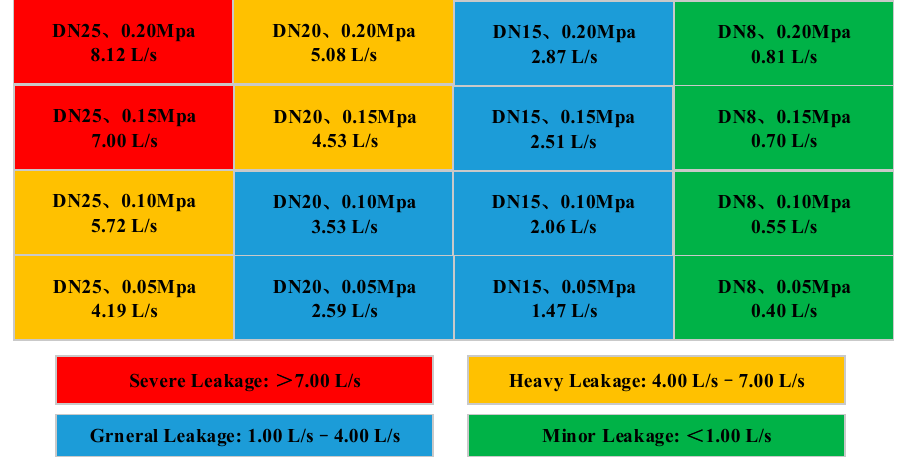
Figure 18. Leakage level groups.